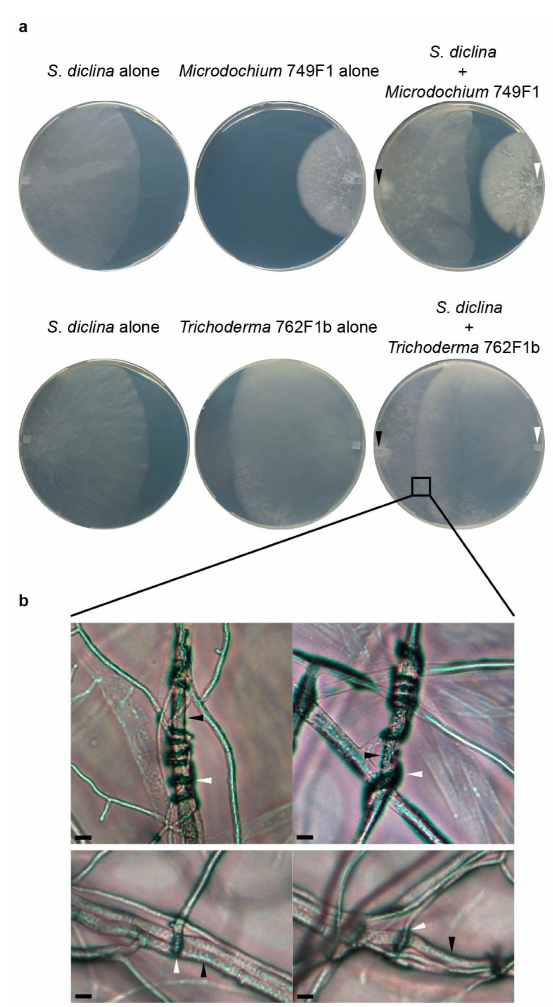
Figure 4. In vitro activities of Microdochium and Trichoderma isolates. ( a ) Dual culture of Microdochium isolate 749F1 or Trichoderma isolate 762F1b with Saprolegnia diclina 1152F4 on 1/5th strength potato dextrose agar (1/5PDA). S. diclina and the fungal isolates were pre-grown on 1/5PDA. A hyphal plug of S. diclina was inoculated on the left side of the fresh 1/5PDA and a hyphal plug of Microdochium isolate 749F1 or Trichoderma isolate 762F1b was inoculated on the right side. The dual cultures were incubated for six days at 20–25 ˝ C. The black arrows indicate S. diclina plugs and the white arrows indicate Microdochium or Trichoderma plugs; ( b ) Microscopic pictures of the hyphal interaction between Trichoderma and S. diclina . The black arrows indicate hyphae of S. diclina . The white arrows indicate the coiling of Trichoderma hyphae around S. diclina hyphae ( top pictures) or the formation of papilla-like structure of Trichoderma hyphae around S. diclina hyphae ( bottom pictures). Scale bars represent 10 µ